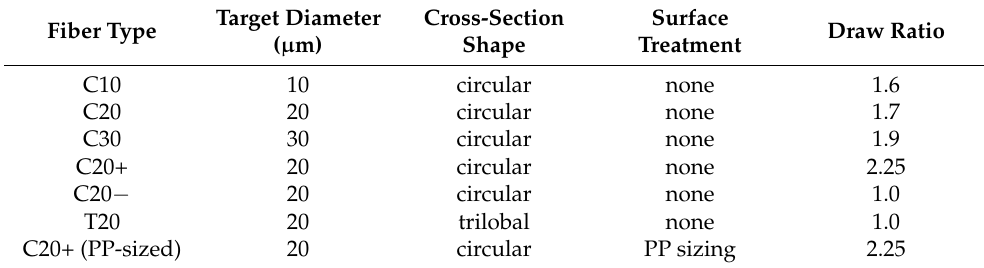
Table 1. Overview of endless polypropylene fibers manufactured by melt-spinning.